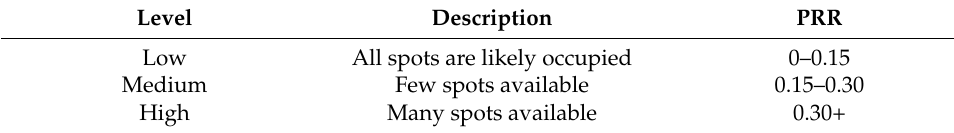
Table 2. PRR Classification.